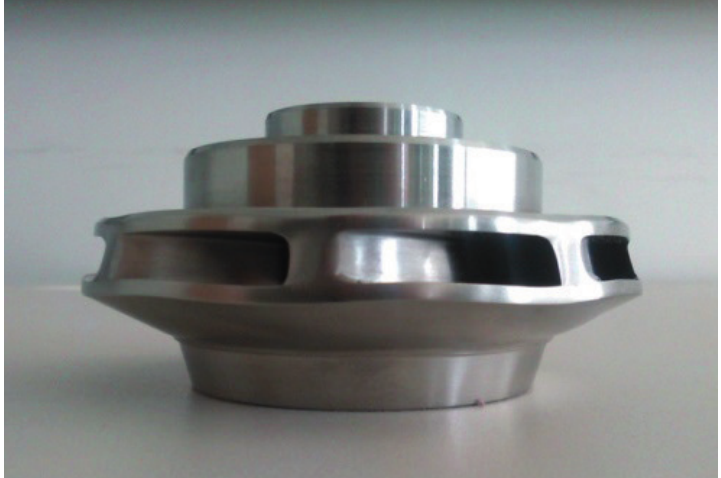
Figure 15. Strong plastic deformation of a stainless steel